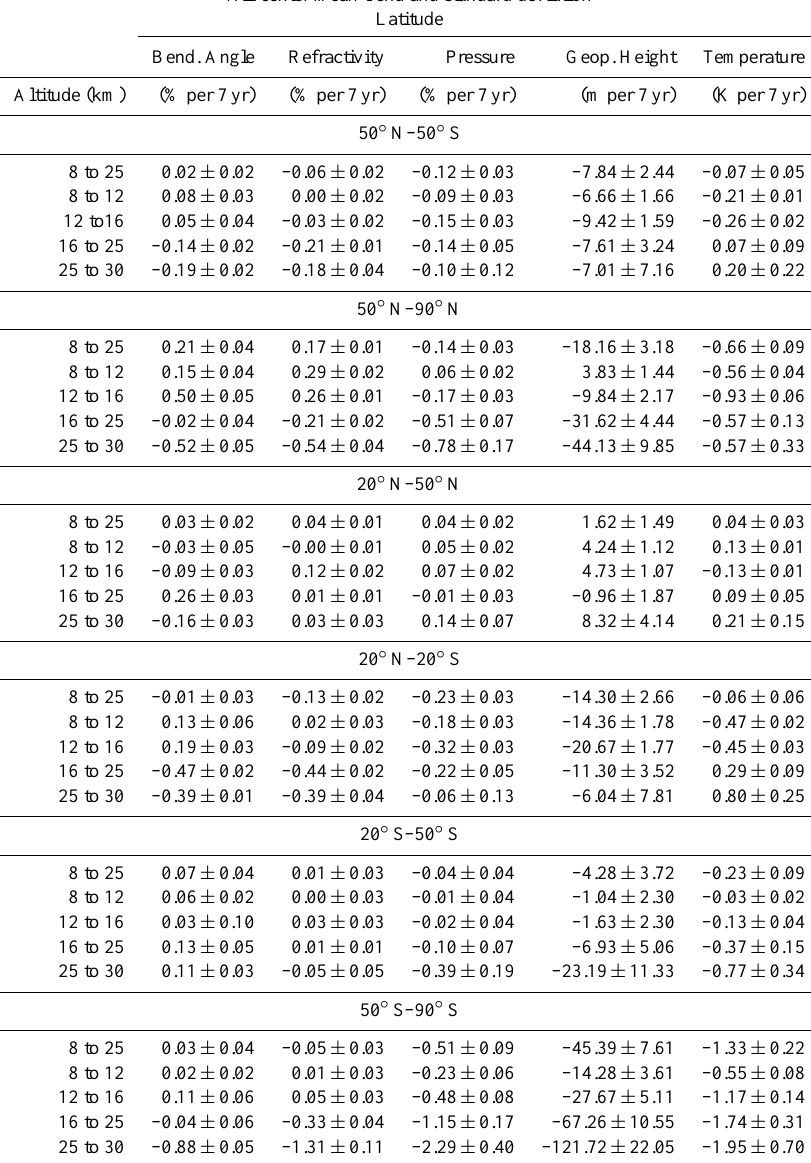
Table 2. Mean trend (all-center mean) and standard deviation of the trend for six latitude regions and five altitude layers, for bending angle, refractivity, pressure, geopotential height, and temperature. The all-center mean includes DMI, EUM, GFZ, JPL, UCAR, WEGC for bending angle, and DMI, GFZ, JPL, UCAR, WEGC for refractivity to temperature. The estimated sampling error was subtracted for each parameter except for bending